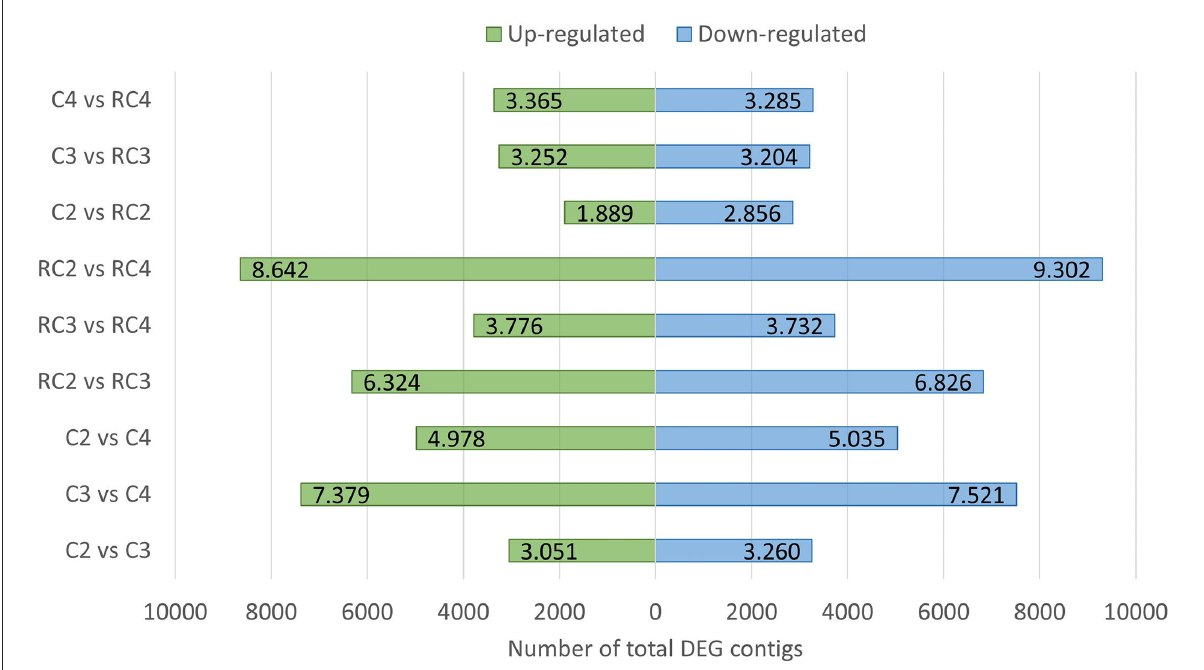
FIGURE4 Up and down expressed genes in the different developmental and ripening stages. Contigs with a fold change ≥ [2] between the two samples are indicated. In each comparison, the first sample is the testing one, and the second is the control. The analysis was performed on 77,181 contigs, as 127,573 contigs were not considered for having at least one zero FPKM value in any of the libraries.